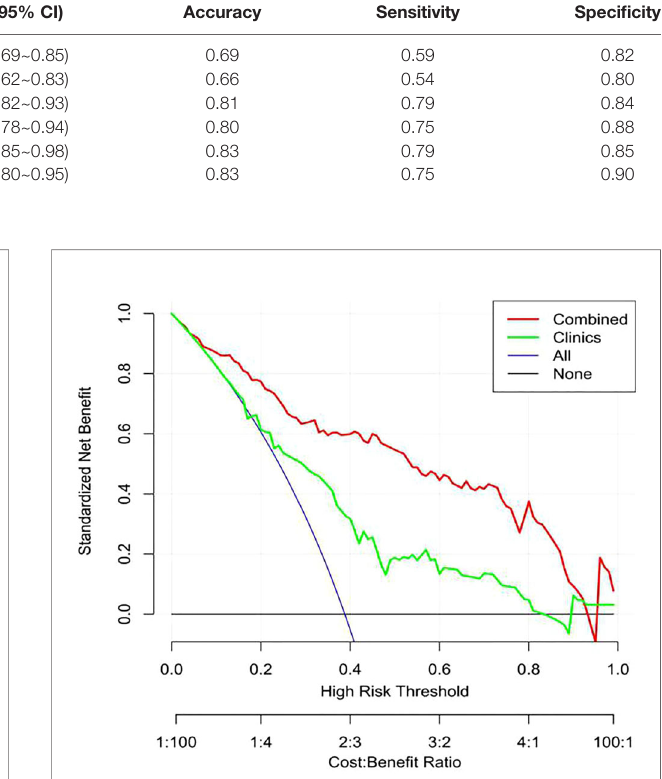
FIGURE 9 | Decision curveanalysis(DCA)ofthe nomogram.The y-axisshows netincome, the red line represents the radiomics nomogram, the blueline represents the hypothesisthatall patients have highKi-67 expression,and the black line represents thehypothesisthat no patient has high Ki-67 expression. The x-axisshows the threshold probability — that is, the expected bene fi t of the number of treatments equalsthe expected bene fi t of not receiving treatment. The decision curve shows that when the threshold probability is between 0.1 and1, usinga radiomics nomogram to predict Ki-67 expression ismore bene fi cial than treating all patients ornot treating patients.